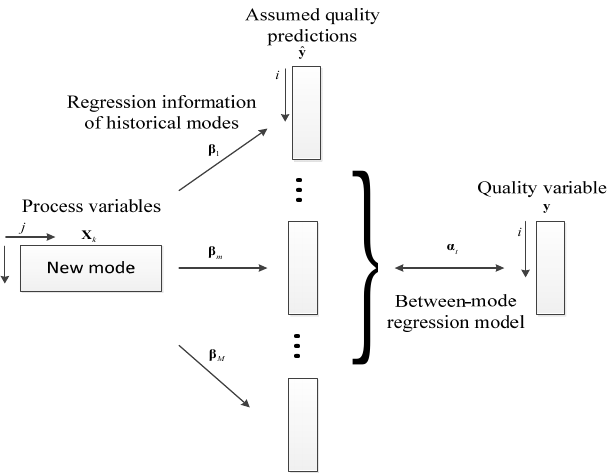
Figure 2. Illustration of between-mode quality regression modeling.